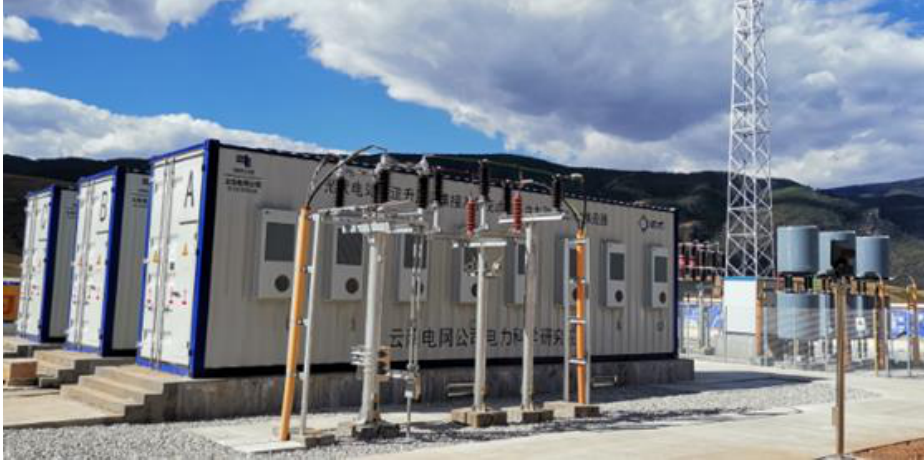
Figure 26. ±30 kV MMC converter to simulate HVDC grid.